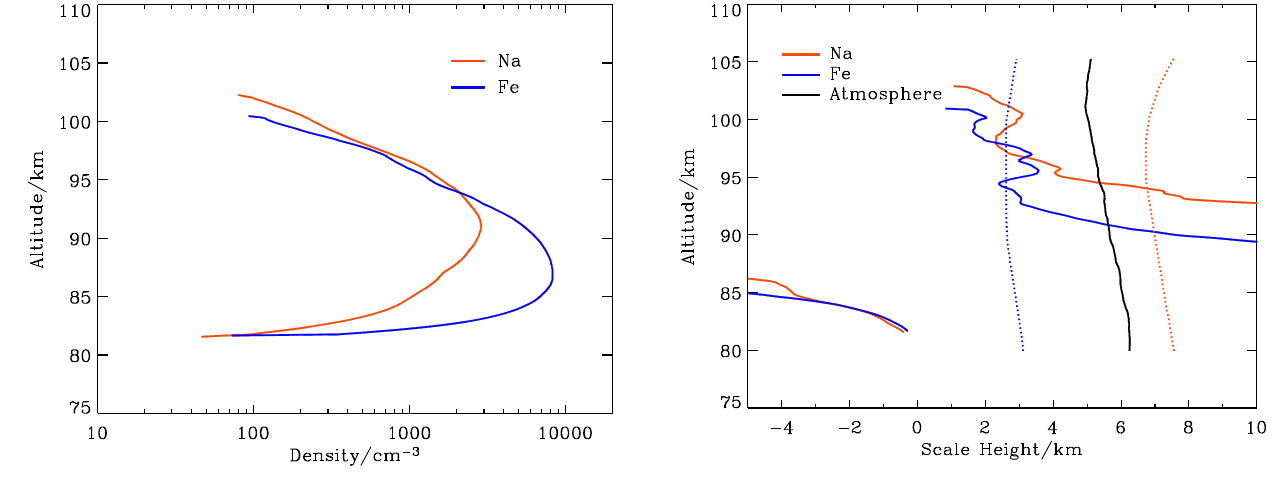
Fig. 2. Annual mean Na and Fe profiles derived based on a total of ∼ 268h of simultaneous and nearly common-volume Na and Fe lidar measurements from March 2004 to December 2008 at 30 ◦ N (the averaging method is depicted in text). The profiles have been smoothed with a running mean over 1.2km in altitude. Note that the mean Na or Fe density profile can preserve the sharp gradients present in most individual density profiles near the layer bottom.